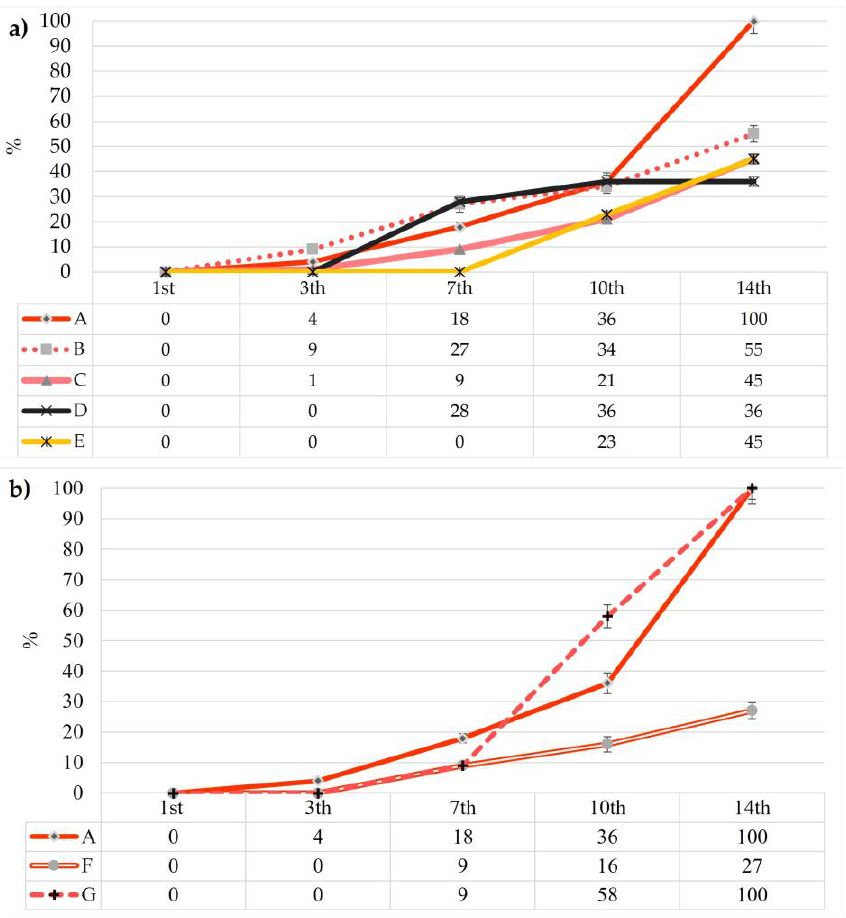
Figure 3. Effects of edible coatings enriched with AE ( a ) and BEO ( b ) on decay index values of strawberries during storage.